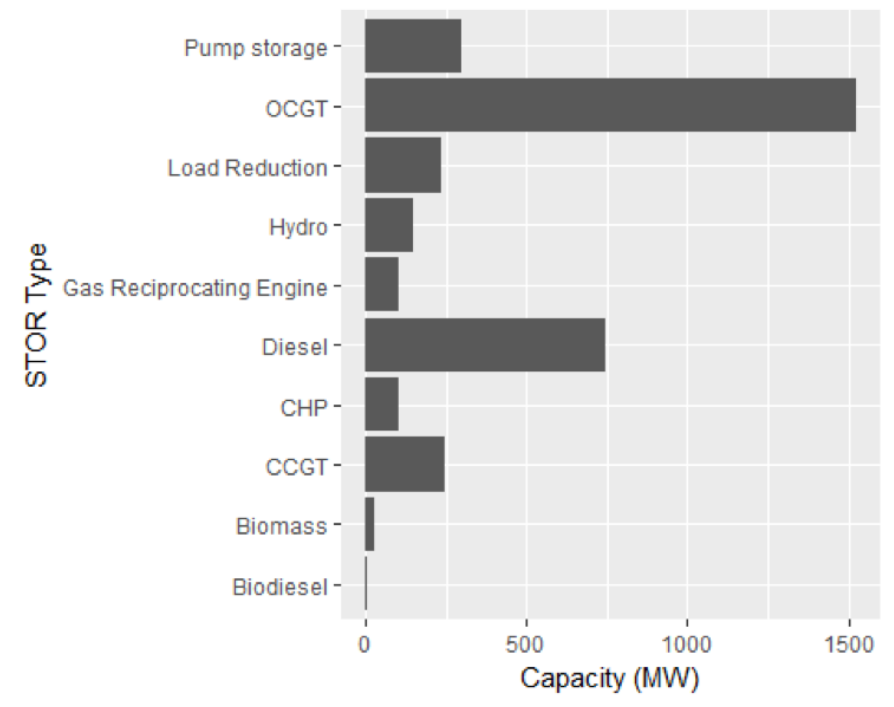
Figure 1. Short Term Operating Reserve (STOR) capacity by fuel type in MW in the UK